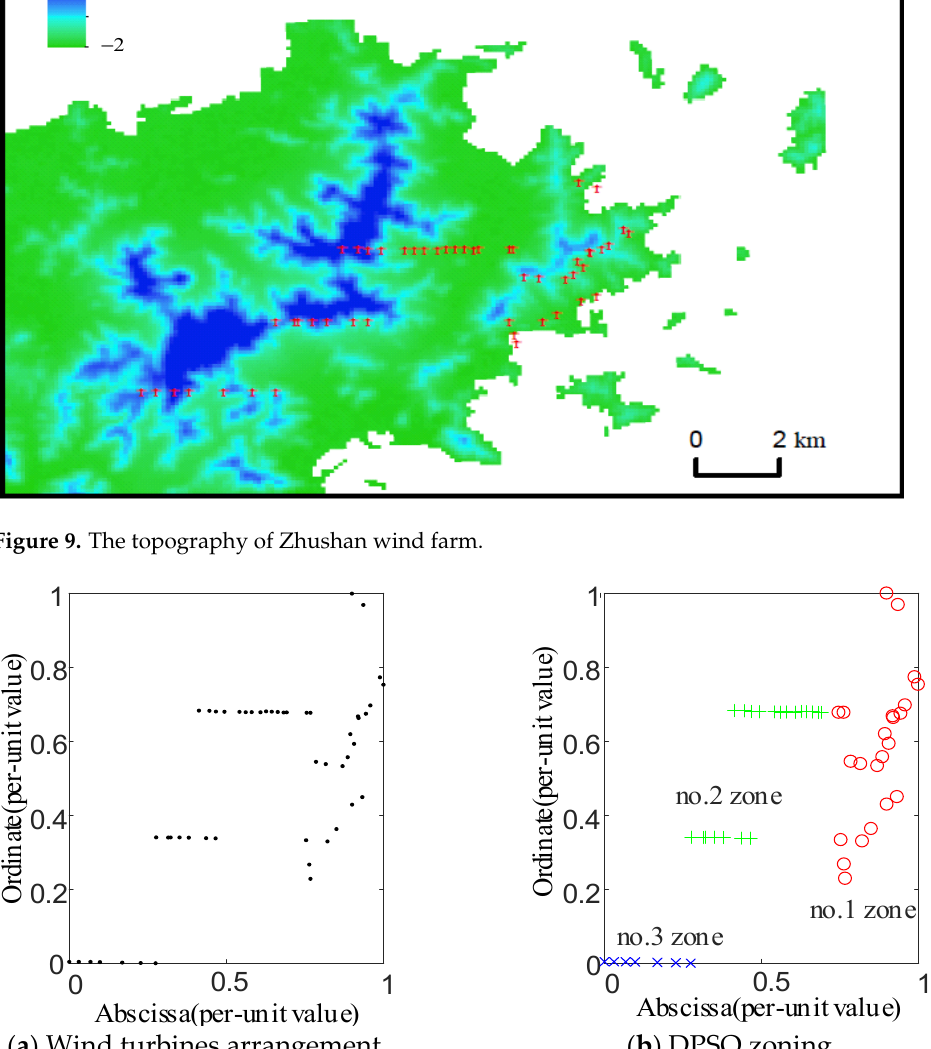
Figure 10. Optimal zoning result of Zhushan wind farm.